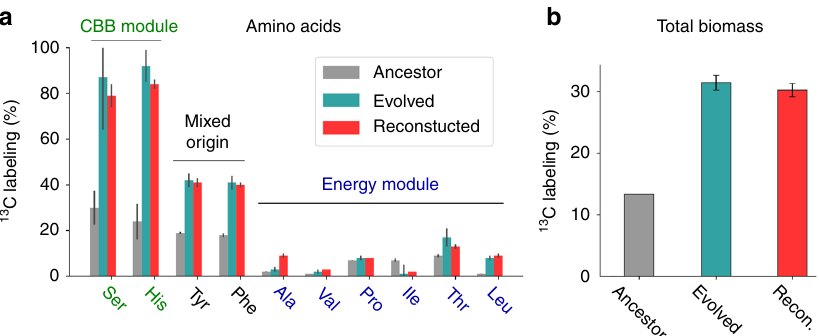
Fig. 3 Validation of the hemiautotrophic phenotype in the reconstructed strain. a We grew the reconstructed, evolved, and ancestral clones with isotopically labeled 13 CO 2 as an inorganic carbon source and non-labeled pyruvate as an energy source, and performed isotopic labeling analysis. Amino acids derived from the CBB cycle (e.g., serine) are labeled green, whereas amino acids derived from the energy module (e.g., alanine) are in blue. As predicted for a hemiautotrophic growth mode, amino acids derived from the intermediates of the CBB module are almost fully labeled in the reconstructed and evolved strain but not in the ancestor strain. In marked contrast, amino acids derived from the TCA and lower glycolysis (energy module) show low levels of labeling. This validates that the reconstructed and evolved strains synthesize CBB module biomass precursors from CO 2 using the non-native CBB cycle. b We propagated cells in minimal media supplemented with non-labeled pyruvate (5 g/L) and labeled 13 CO 2 atmosphere (0.1 atm). We used an elemental mass analyzer to measure the isotopic carbon composition in the total cell biomass (mean ± SD; n = 4). The reconstructed strain shows one- third of cellular carbon originated from fi xed inorganic carbon, a value similar to the evolved strains and in line with the expected fraction of biomass precursors originating from the CBB module. The ancestor strain required the addition of xylose (non-labeled, 0.2 g/L) for growth. Labeled carbon in the ancestor strain results from the RuBisCO-dependent catabolism of xylose and from the assimilation of inorganic carbon via anaplerotic